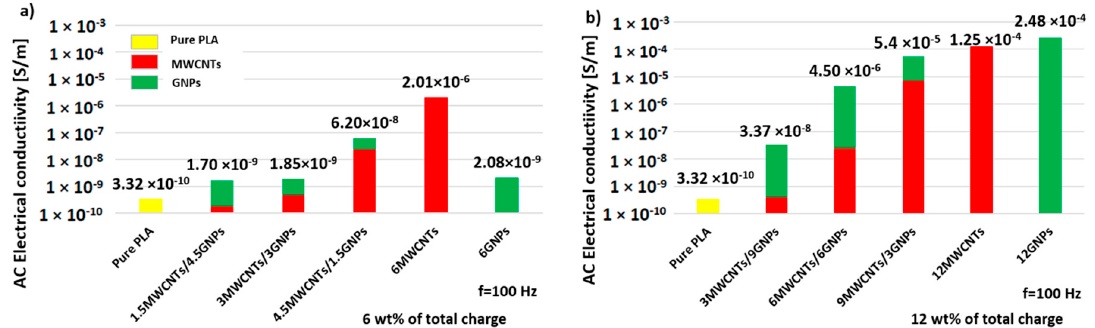
Figure 12. Comparison for the electrical conductivities (at 100 Hz) achieved for hybrid systems at two filler concentrations: 6 wt % in ( a ) and 12 wt % in ( b ), respectively.